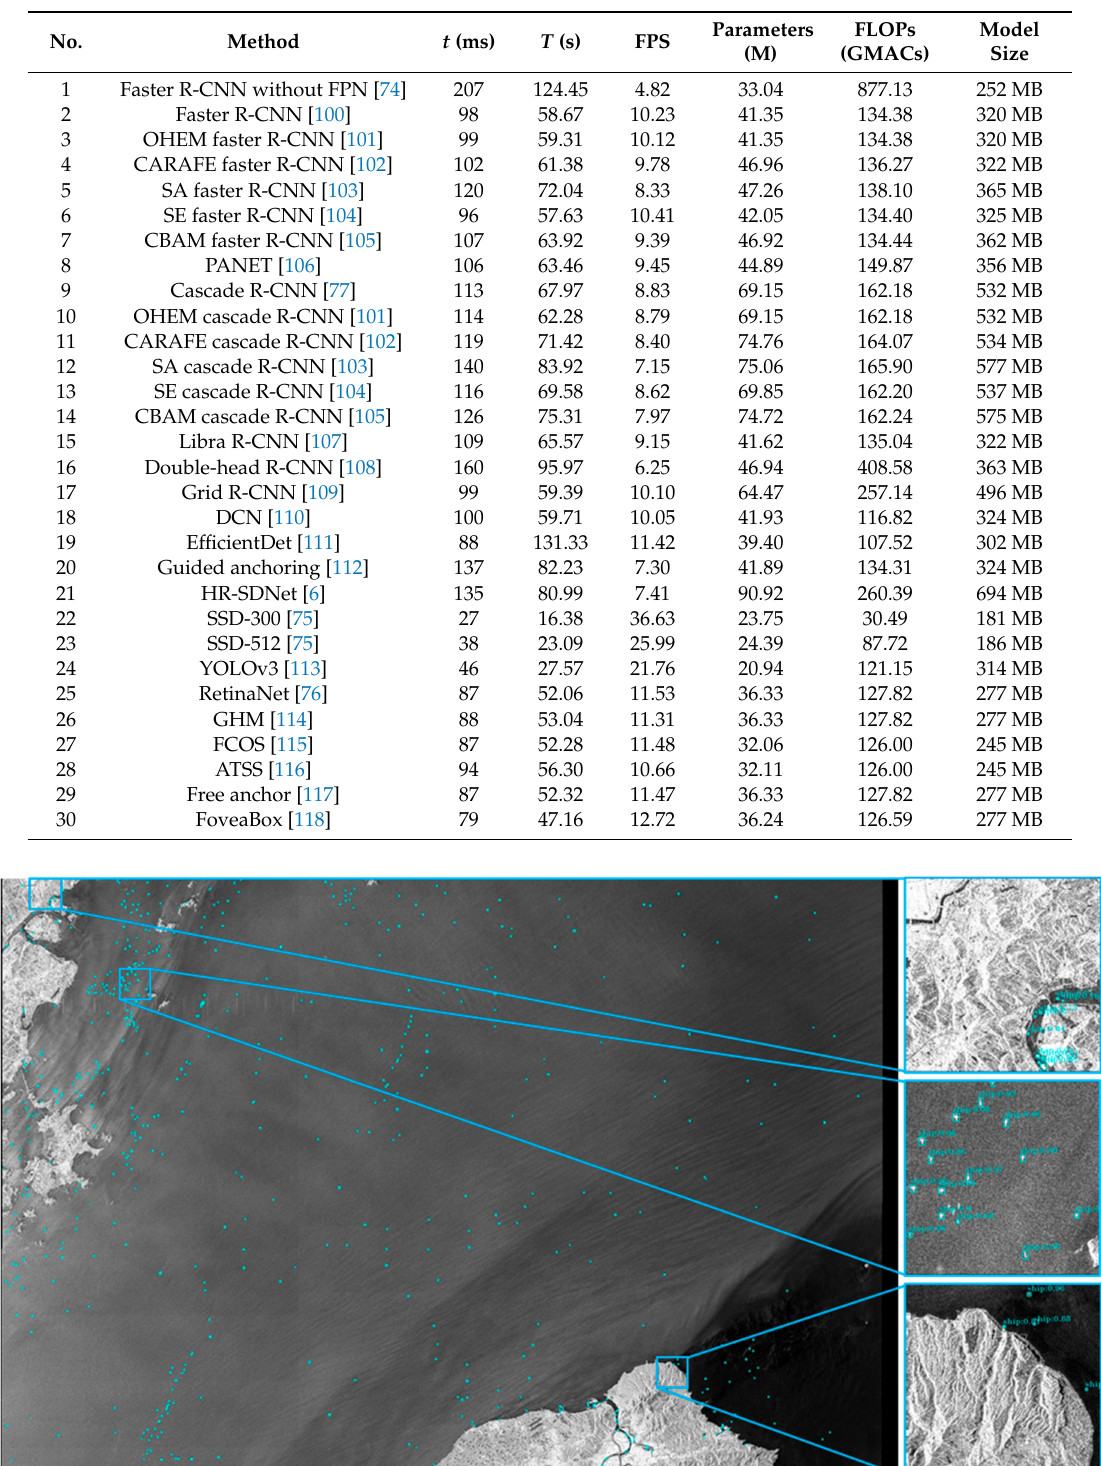
Table 12. Detection speed and model information. t : the time to detect a sub-image. T : the time to detect a large-scale image. FPS: frames per second of detecting sub-images. Parameters: network parameter number. FLOPs: floating point of operations (giga multiply add calculations, GMACs) [124].